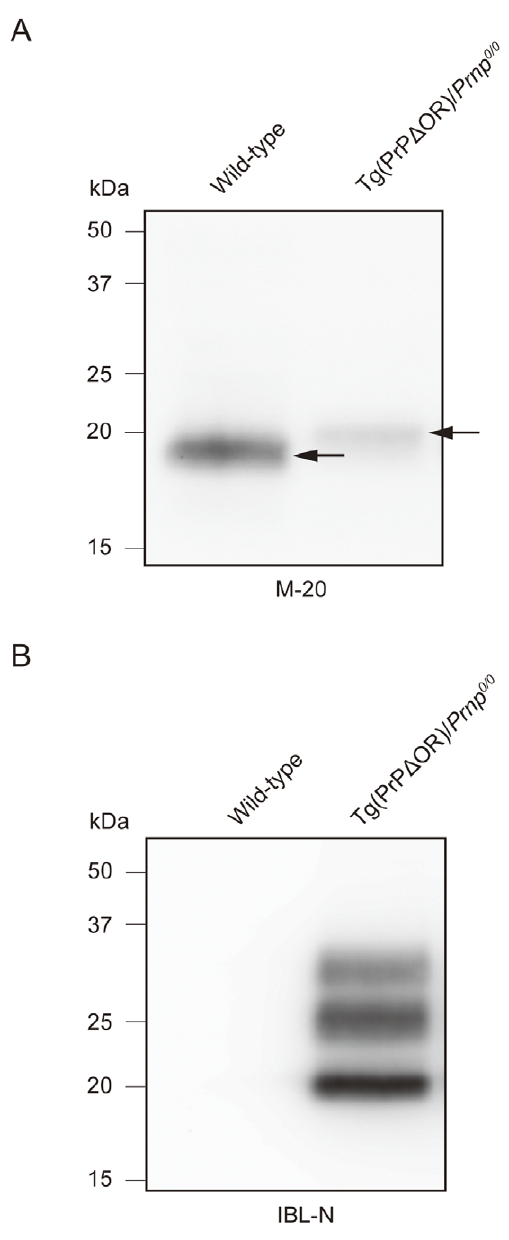
Figure 4. The pre-OR region of PrP Sc D OR is PK-resistant. (A) The brain homogenates of terminally ill wild-type and tg(PrP D OR)/ Prnp 0/ 0 mice were treated with PNGase F after digestion with PK, and subjected to immunoblotting with M-20 anti-PrP antibodies. The deglycosylated PK-resistant band of PrP Sc D OR was higher in molecular size than that of full-length PrP Sc . Arrows indicates PK-resistant deglycosylated PrPs. (B) The brain homogenates from terminally ill wild-type and tg(PrP D OR)/ Prnp 0/0 mice were digested with PK, and subjected to immunoblotting with N-terminus-specific IBL-N anti-PrP antibody. The IBL-N antibodies recognized the PK-resistant PrPs from PrP Sc D OR but not from full-length PrP Sc .